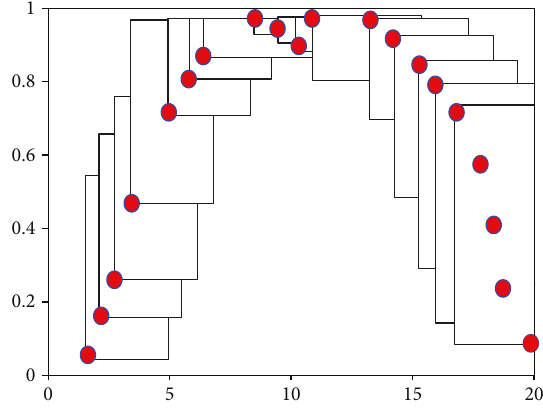
Figure 6: Bootstrap operation process